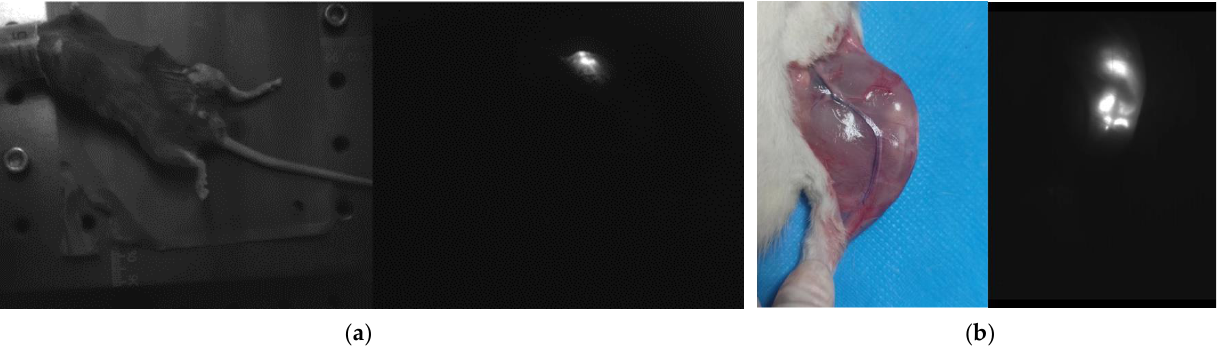
Figure 2. Pre-shot pictures of our previous equipment. ( a )Wide-band camera and fixed-focus lens imaging. ( b )Camera imaging at different wavelengths and positions.